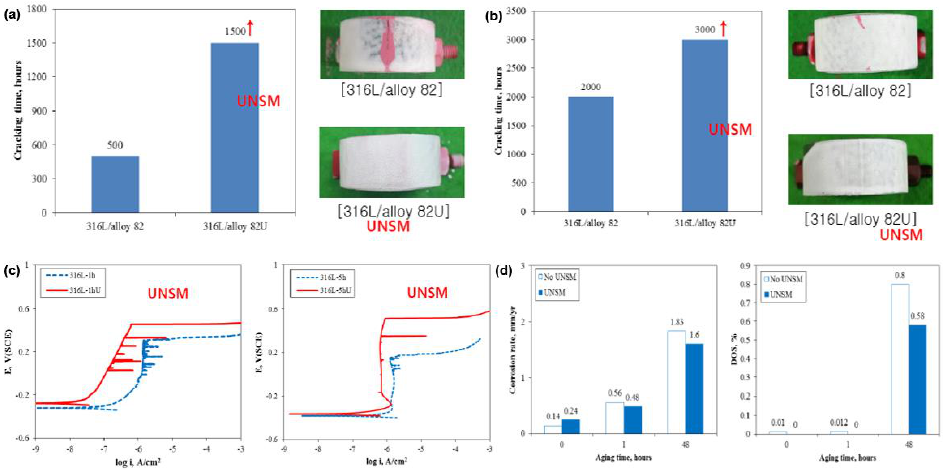
Figure 8. Improvements in SCC resistance ( a ), corrosion resistance ( b ), and corrosion rate of AISI 316L ( c ) and Ni Alloy 82 ( d ). ( c ) and Ni Alloy 82 ( d